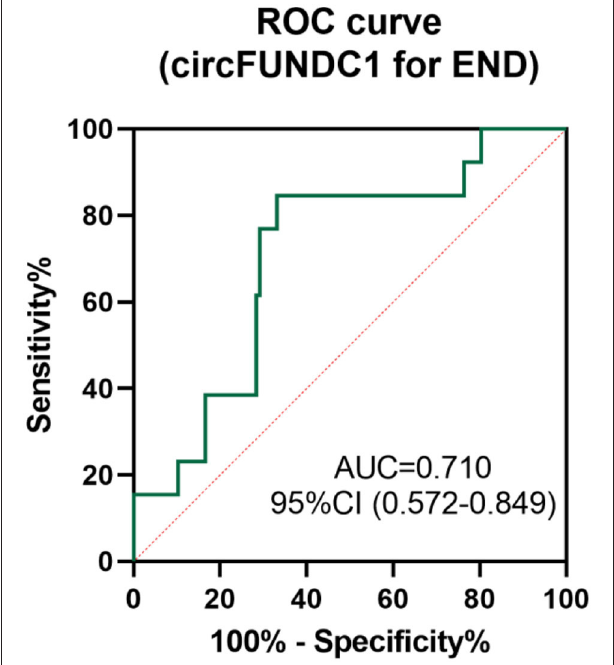
FIGURE 6 | Receiver operating characteristic (ROC) curve for the value of circFUNDC1 to predict early neurological deterioration (END). AUC, area under the curve; CI, confidence